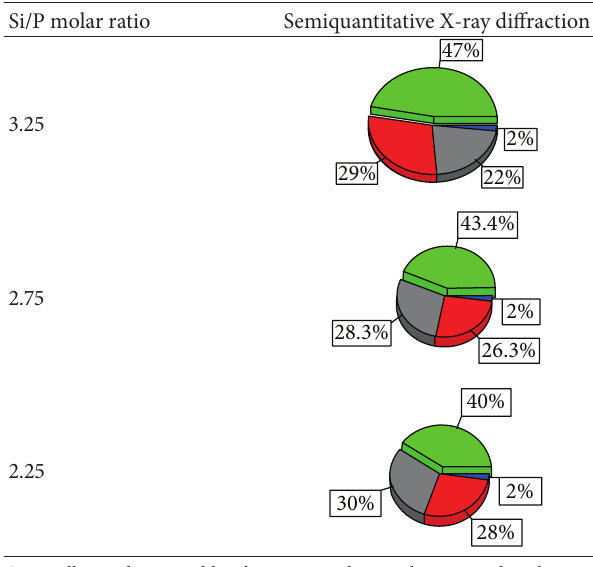
Green: illite, red: quartz, blue: hematite, and gray: aluminum